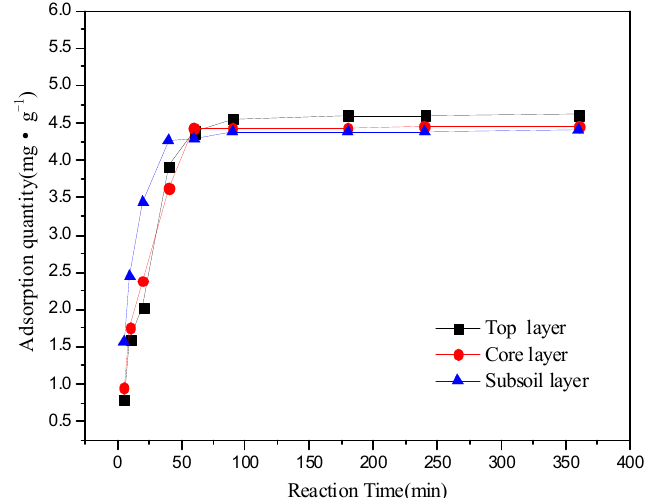
Figure 3. Adsorption kinetic characteristics of each soil. (4 mg of soil, initial concentration of Fe 3+ was 300 mg · L − 1 and the initial pH was 4.20, 25 ◦ C).